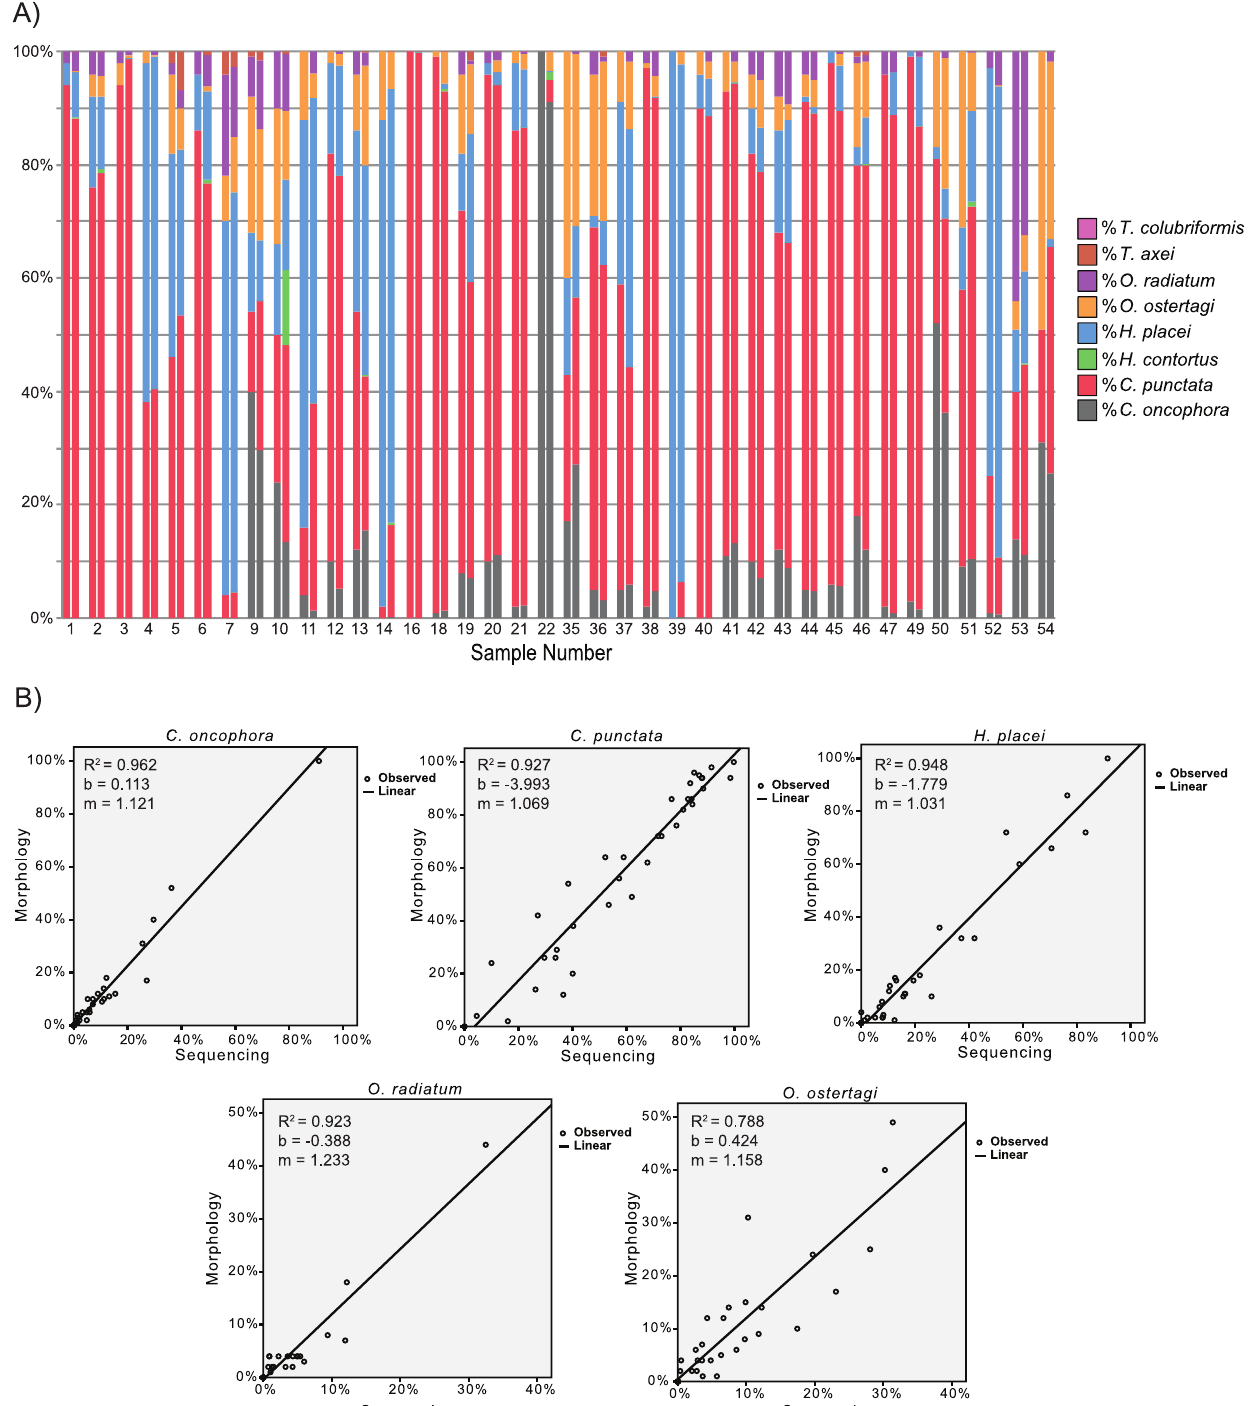
PLOS ONE | DOI:10.1371/journal.pone.0143559 December 2,